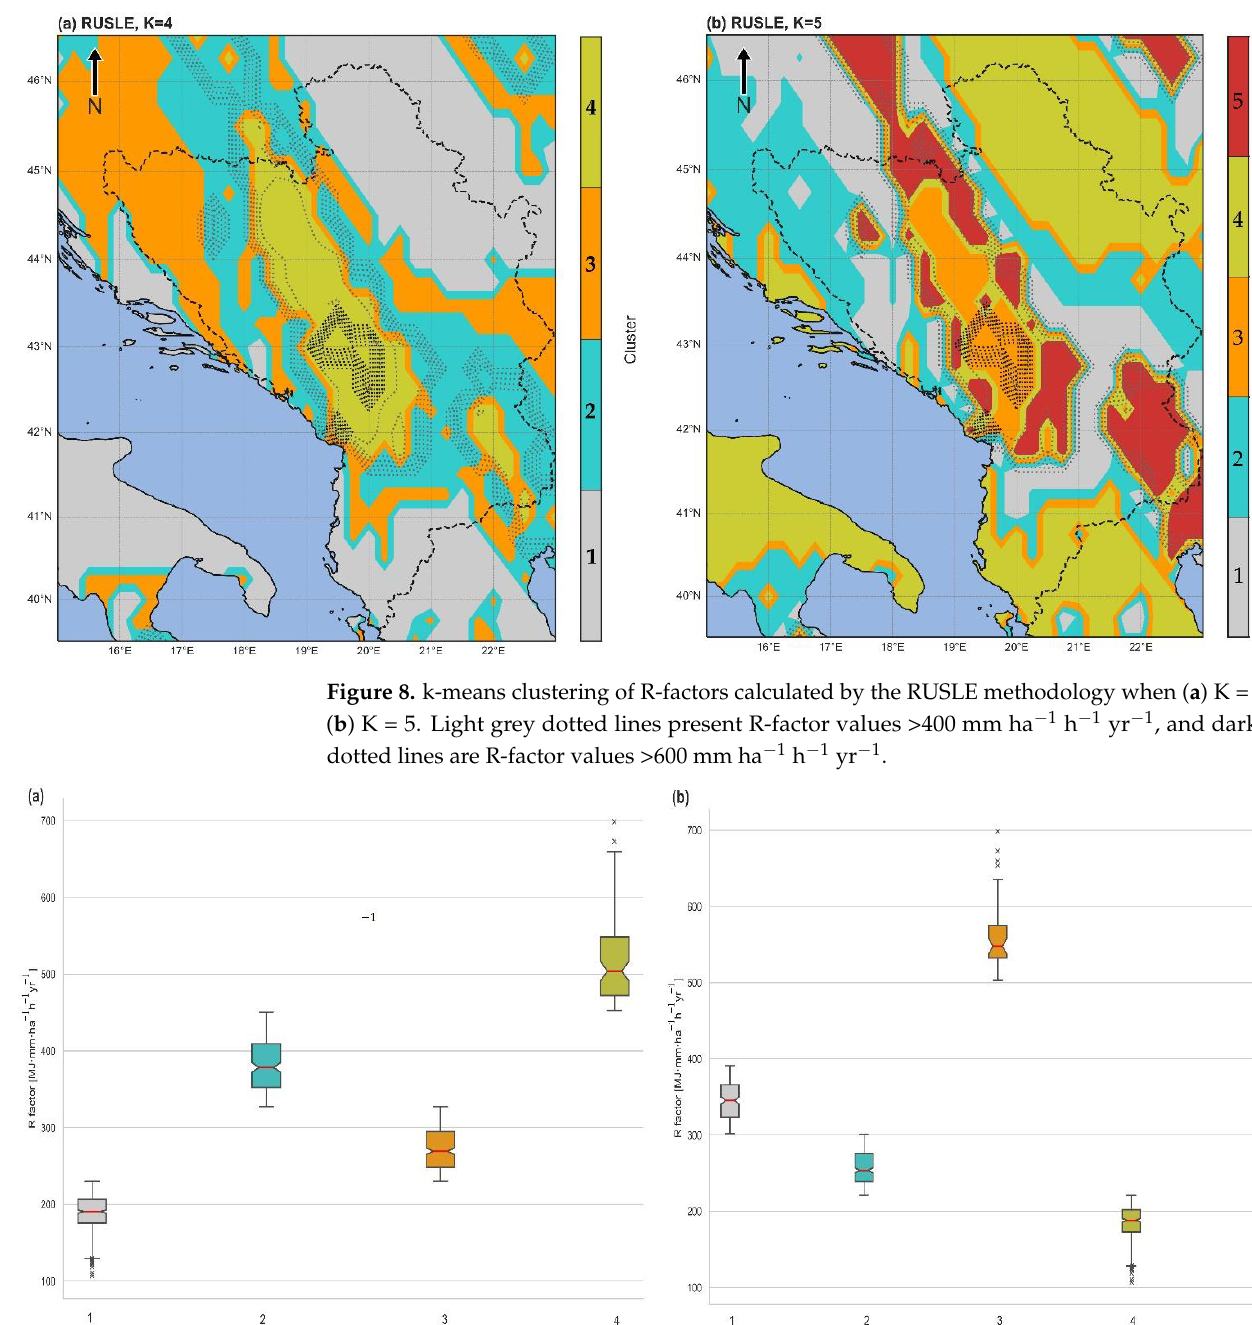
Figure 9. The difference in the R-factor distribution (RUSLE methodology) between the clusters for the total 30-year period if ( a ) K = 4 and ( b ) K = 5.